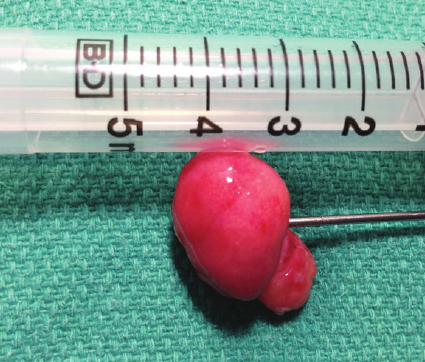
Figure 3: Gross appearance of the lipomatous polyp after resection by argon photocoagulation.